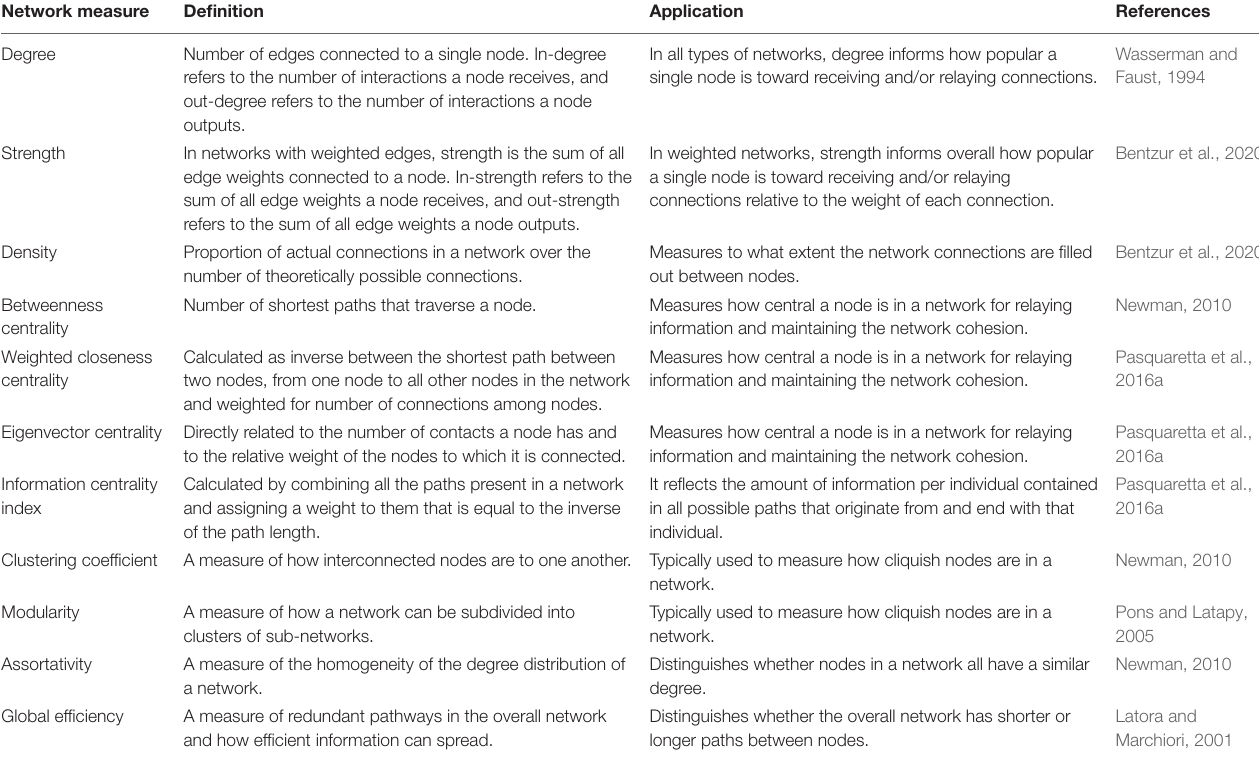
TABLE 1 | A list of common social network measurements defined by their both technical definition and their general applications. Network measure Definition